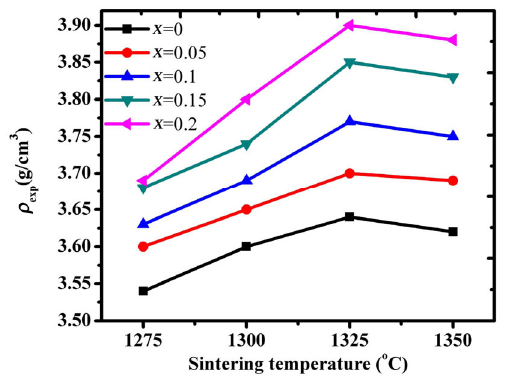
Fig. 1 Variation in experimental density (  exp ) of (1 − x )Mg 0.95 Ni 0.05 Ti 0.98 Zr 0.02 O 3 – x Ca 0.6 La 0.8/3 TiO 3 (0 ≤ x ≤ 0.2) ceramics with sintering temperature.